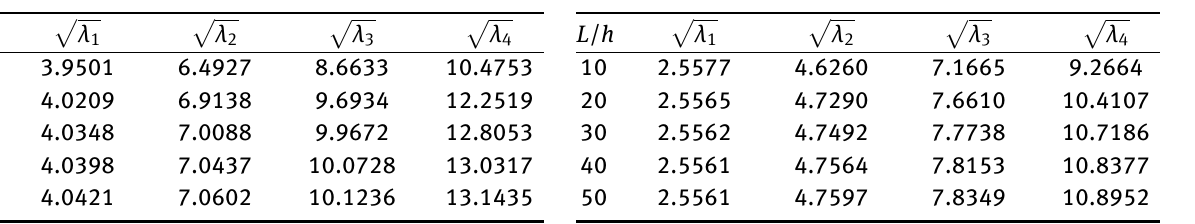
(︁ √ )︁ for CF case for different λ